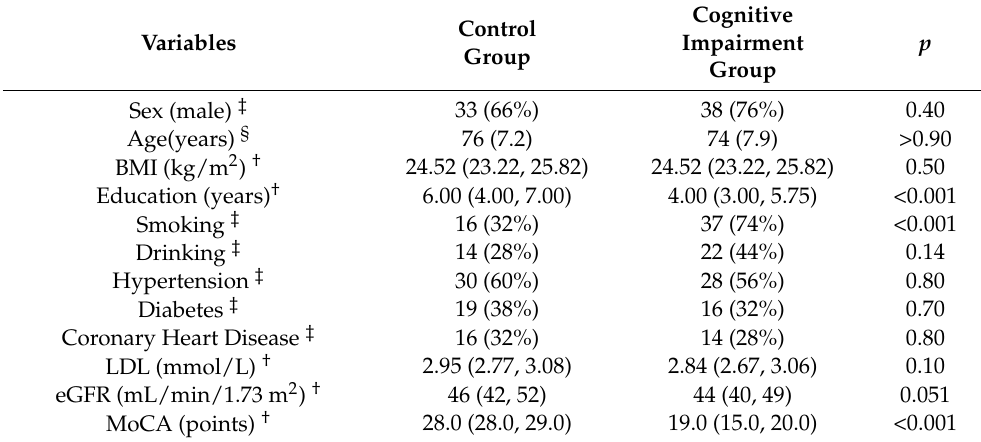
Table 1. Characteristics of the study